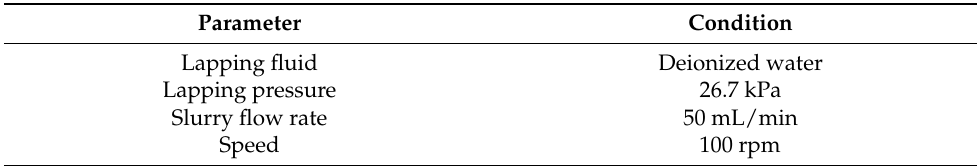
Table 1. Process parameters of lapping experiment. Table 2. Wear test parameters.